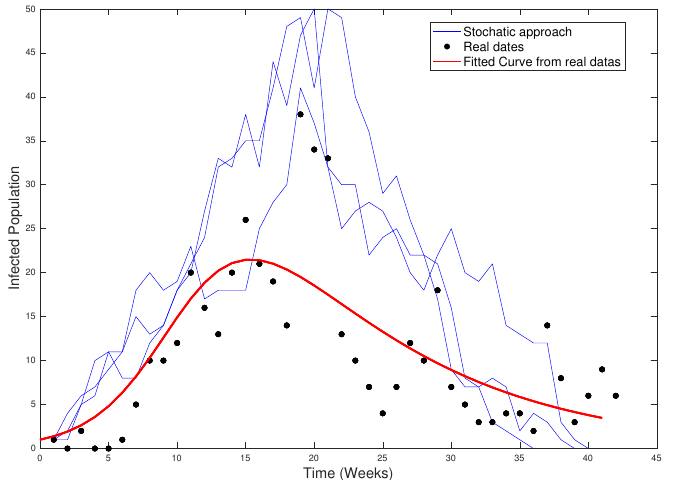
Figure 26. Real data (black), stochastic approach (blue), and fitted curve